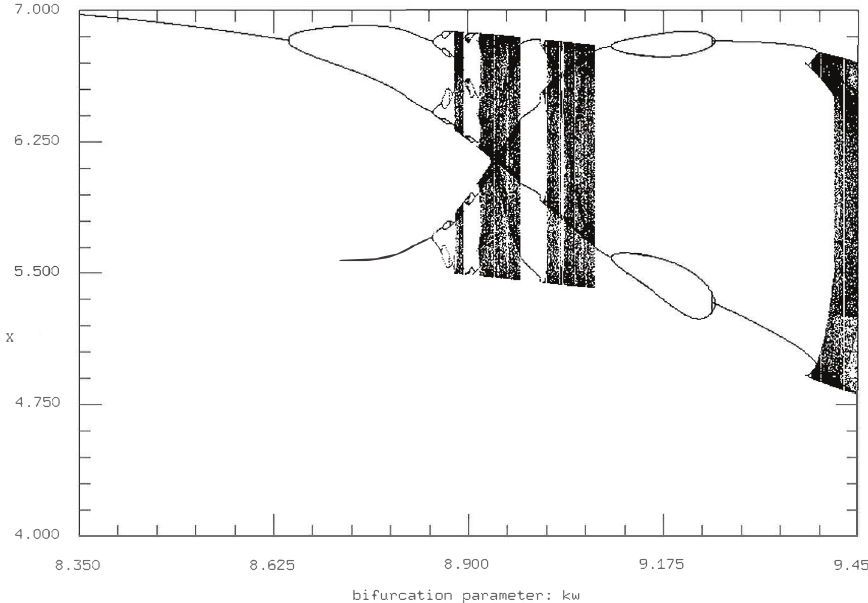
Figure 9. Bifurcation diagram for maxima of X for k w (waste production) with other parameters from Table 1.